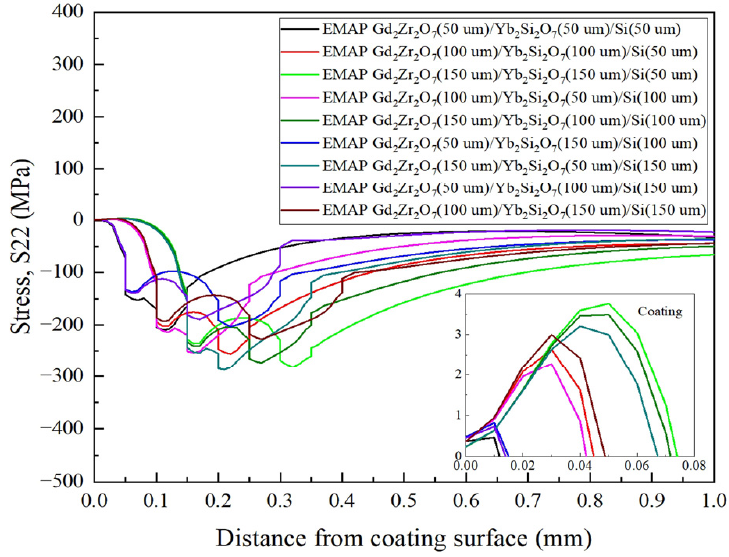
Figure 11. Stress trend of S22_Si_Max as a function of thickness of each layer in EGYS coating system. Figure 12 shows the S22 stress distributions from surface to substrate along the right boundary path in the orthogonal experiments. With the variation of the thickness in the orthogonal experimental group, the S22_Max of the boundary path does not change much (<4 MPa). However, it can still be divided into three regions according to the thickness of the EMAP Gd 2 Zr 2 O 7 layer. This also indicates that the change of the thickness of EMAP Gd 2 Zr 2 O 7 layer has the most significant effect on S22 tensile stress at the boundary, while the Si layer and Yb 2 Si 2 O 7 layer have less effect.